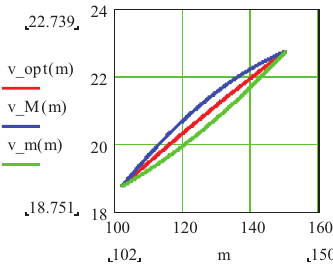
Figure 6. Extremal and its variations The variation function greater than solution (Eq. (10)), v_opt(m) (red curve) (also shown in Figure 2), is depicted as v_M(m) (blue curve); and the variation function less than the solution is designated as v_m(m) (green curve) (see Figure 6).